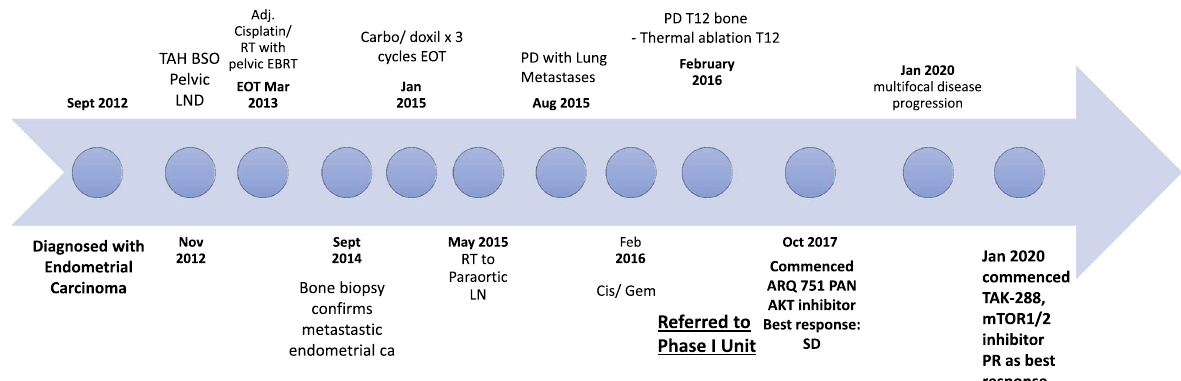
Fig. 1 Treatment timeline. Timeline summarizing treatment course of the patient, including all systemic treatments that the patient